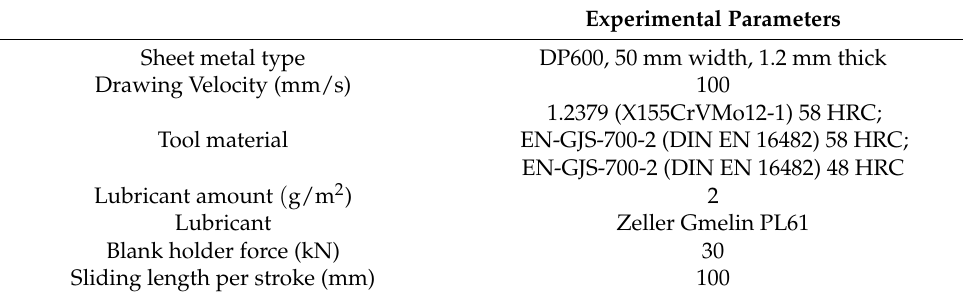
Table 5. Experimental parameters for the wear